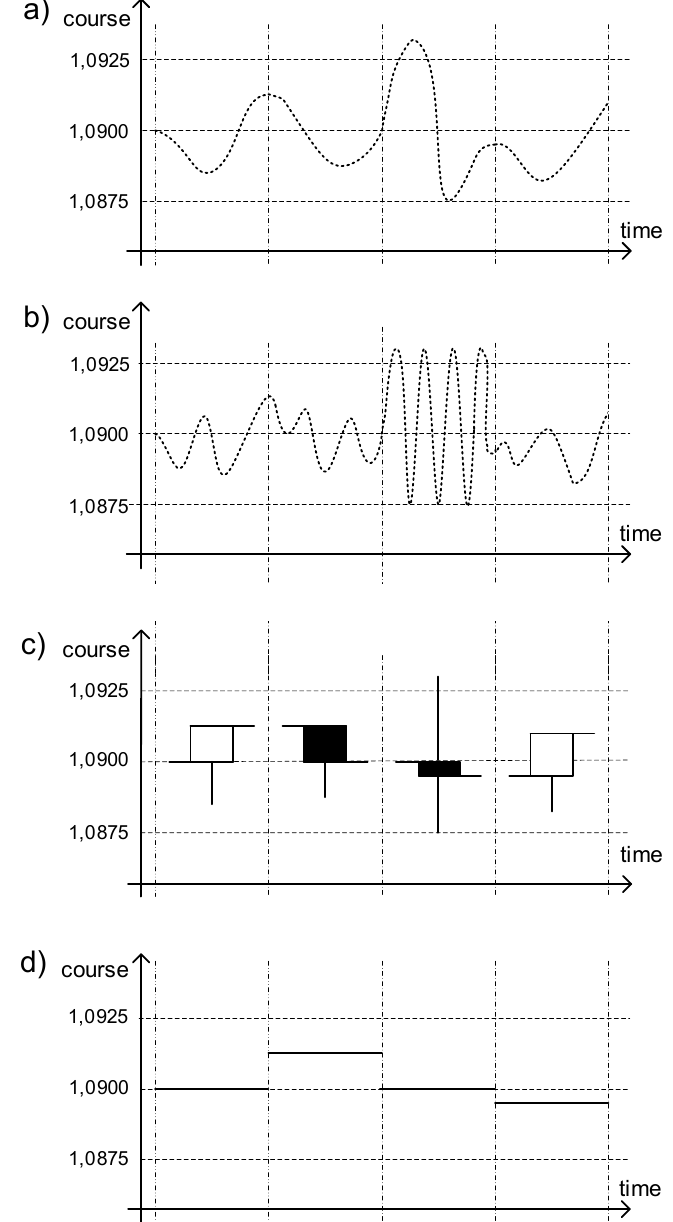
Figure 2. Data representation: ( a ) tick data version 1 ( b ) tick data version 2 ( c ) candlestick representation—one-minute candles ( d ) short candlestick representation (opening prices)—one- minute